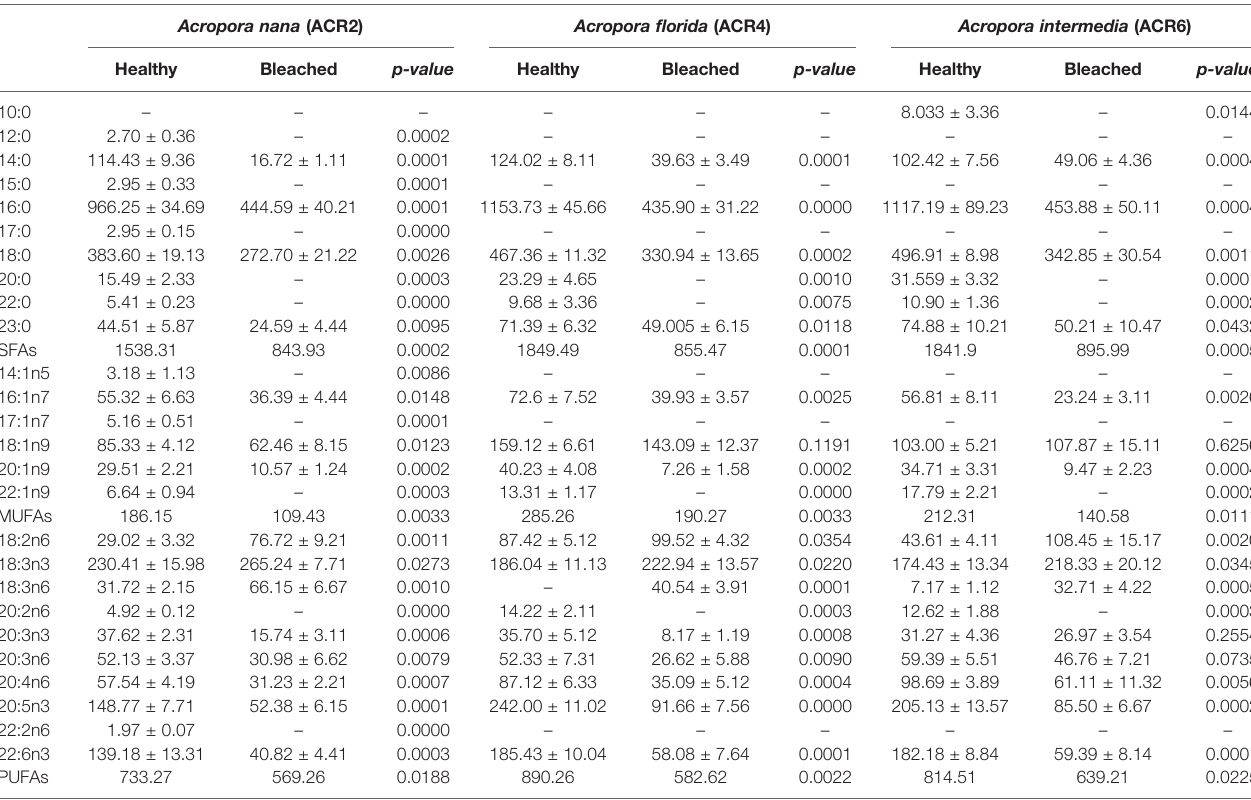
TABLE 4 | Concentration of FAs (µg g − 1 ) of bleached (n = 3) and healthy corals (n = 5).